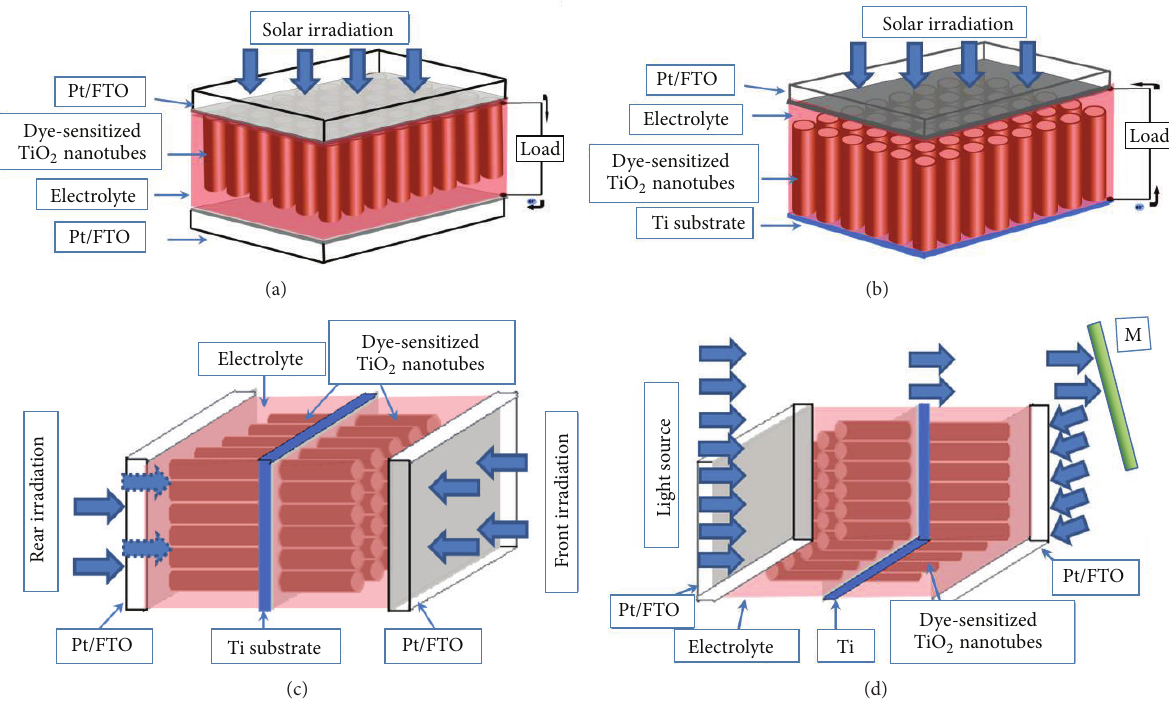
Figure 7: Schematic illustration of front-side illuminated DSSC based on transparent TNAs on FTO substrate (a), backside illuminated DSSC based on TNAs on Ti substrate (b), two light sources illuminated DSSC based on both sides of TNAs on Ti substrate (c), and parallel configuration DSSC with one light source irradiation on double-sided TNAs by using a dielectric mirror